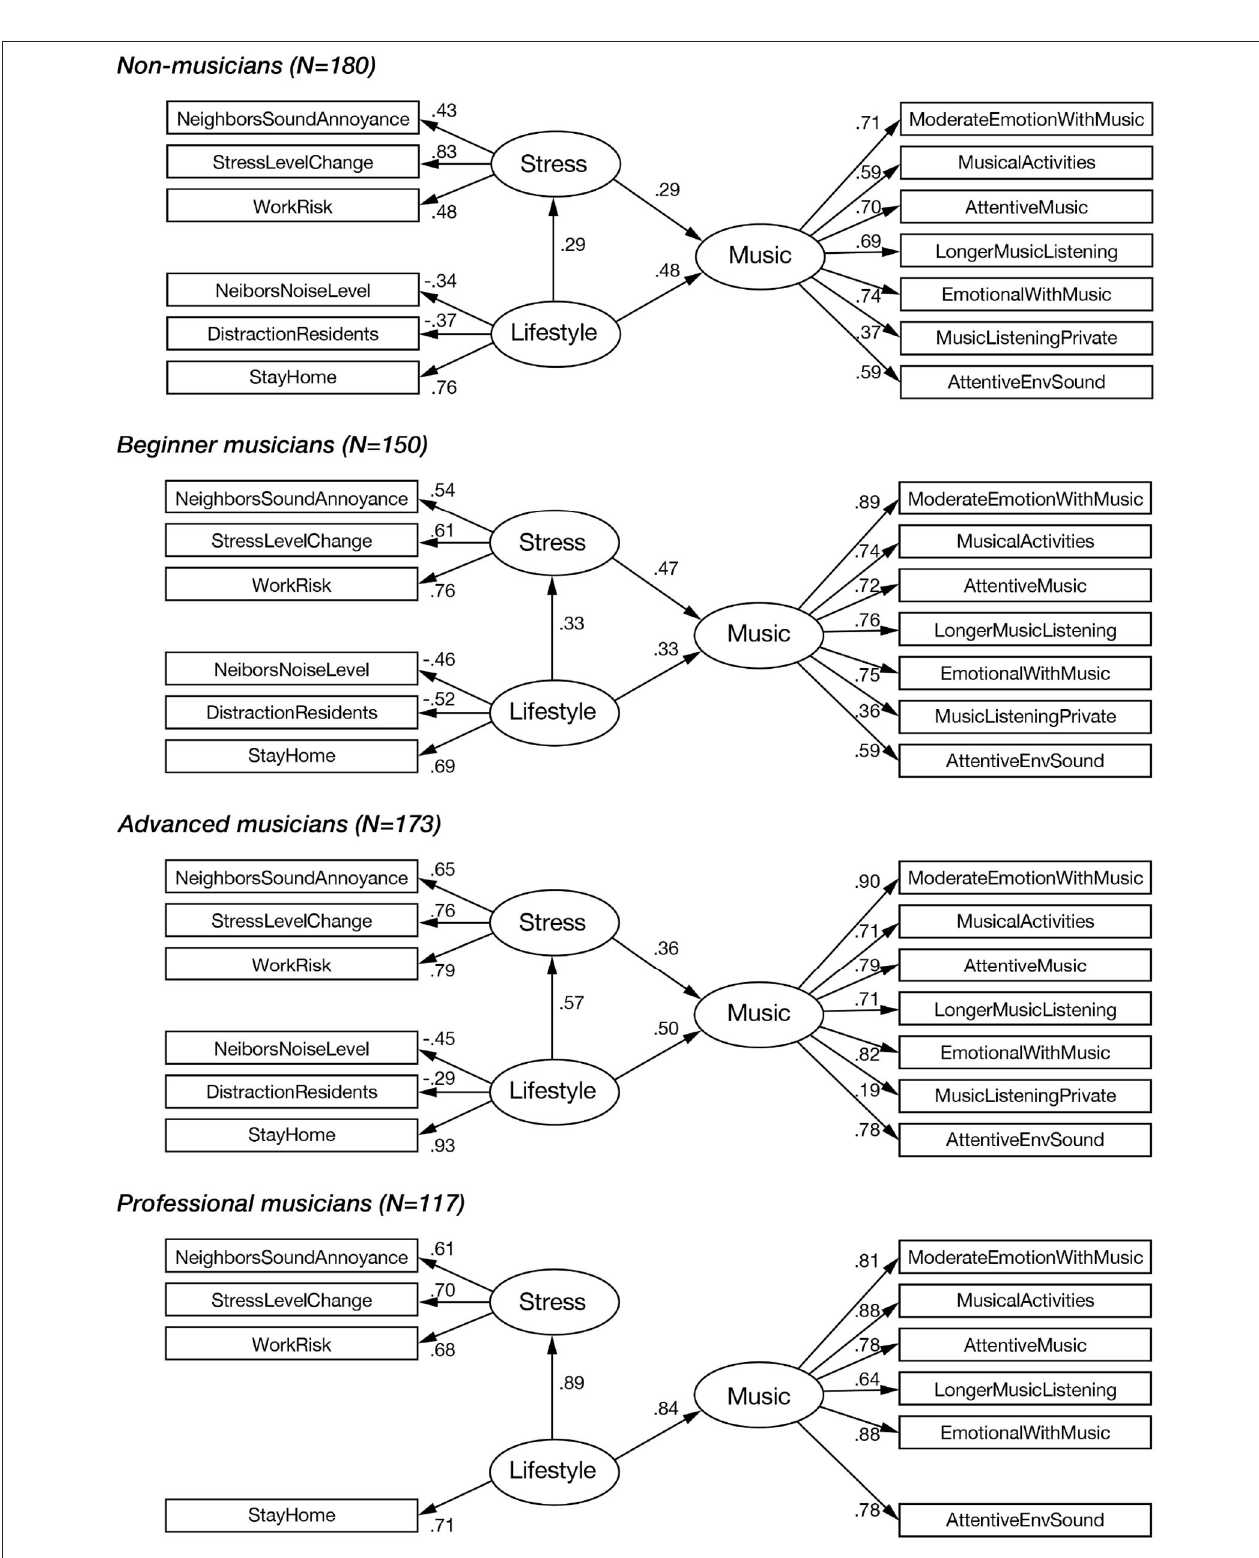
FIGURE 2 | Path diagrams of Multi-group SEM among musicianship. Responses were divided on the musicianship level, and the SEM analysis was applied for each group.